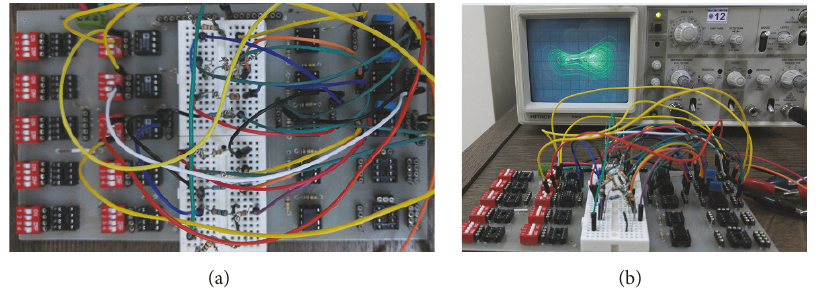
Figure 4: The experimental circuit of the scaled chaotic system.